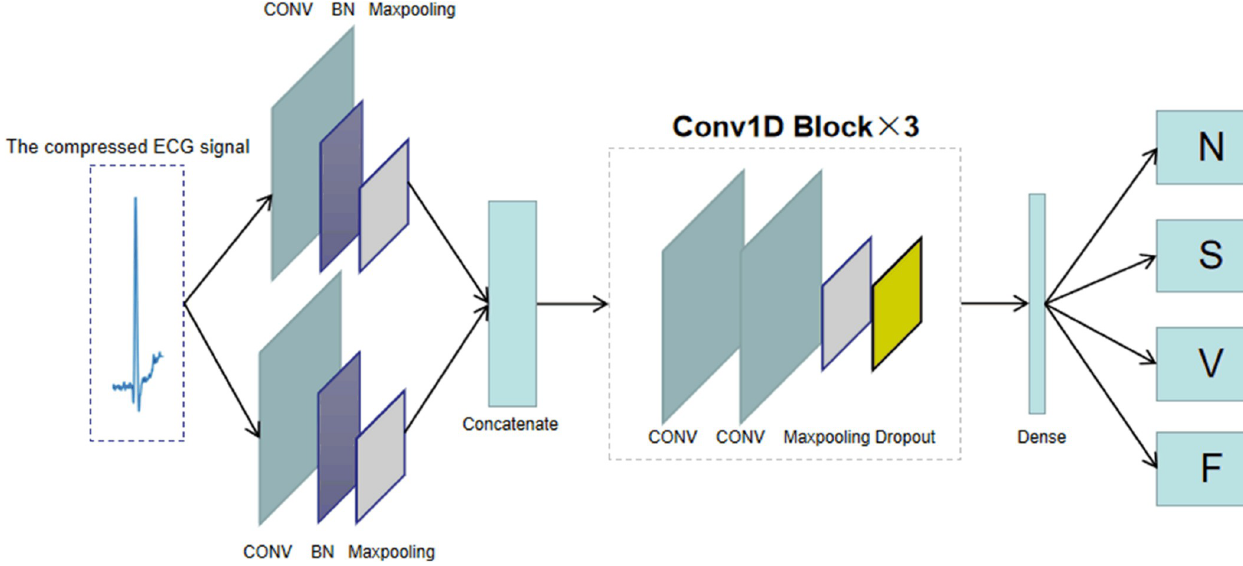
Fig 5. Proposed classification network.